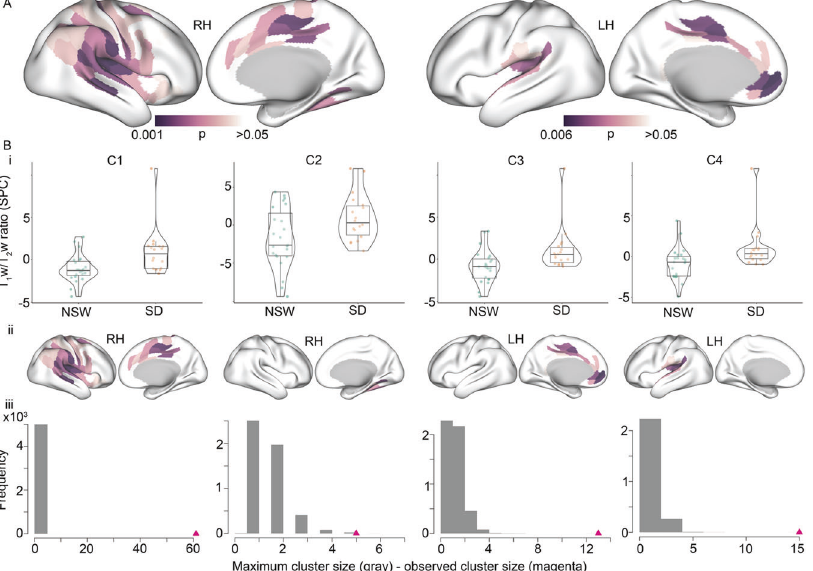
Fig. 2 Altered intracortical T 1 w/T 2 w ratio after 32 h of either normal sleep-wake (NSW) or sleep deprivation. A Surface maps of group differences ( p -values). Displayed are the regions of the four clusters showing signi fi cant group differences in symmetrised percentage change (SPC) in T 1 w/T 2 w ratio between the sleep deprivation group and NSW group in the right hemisphere (RH, left side) and the left hemisphere (LH, right side). Each cluster was p < 0.05, and the p -values for each region (before cluster-correction) are presented for illustration. B Information for each of the 4 clusters (C1-C4). Bi Violin-box-scatter plots for the mean T 1 w/T 2 w ratio for participants in each group. Bii Surface maps of each cluster separately ( p -values). Biii The distribution of maximum cluster sizes across random groupings (grey) with the actual cluster size for each cluster identi fi ed with the triangle (magenta).